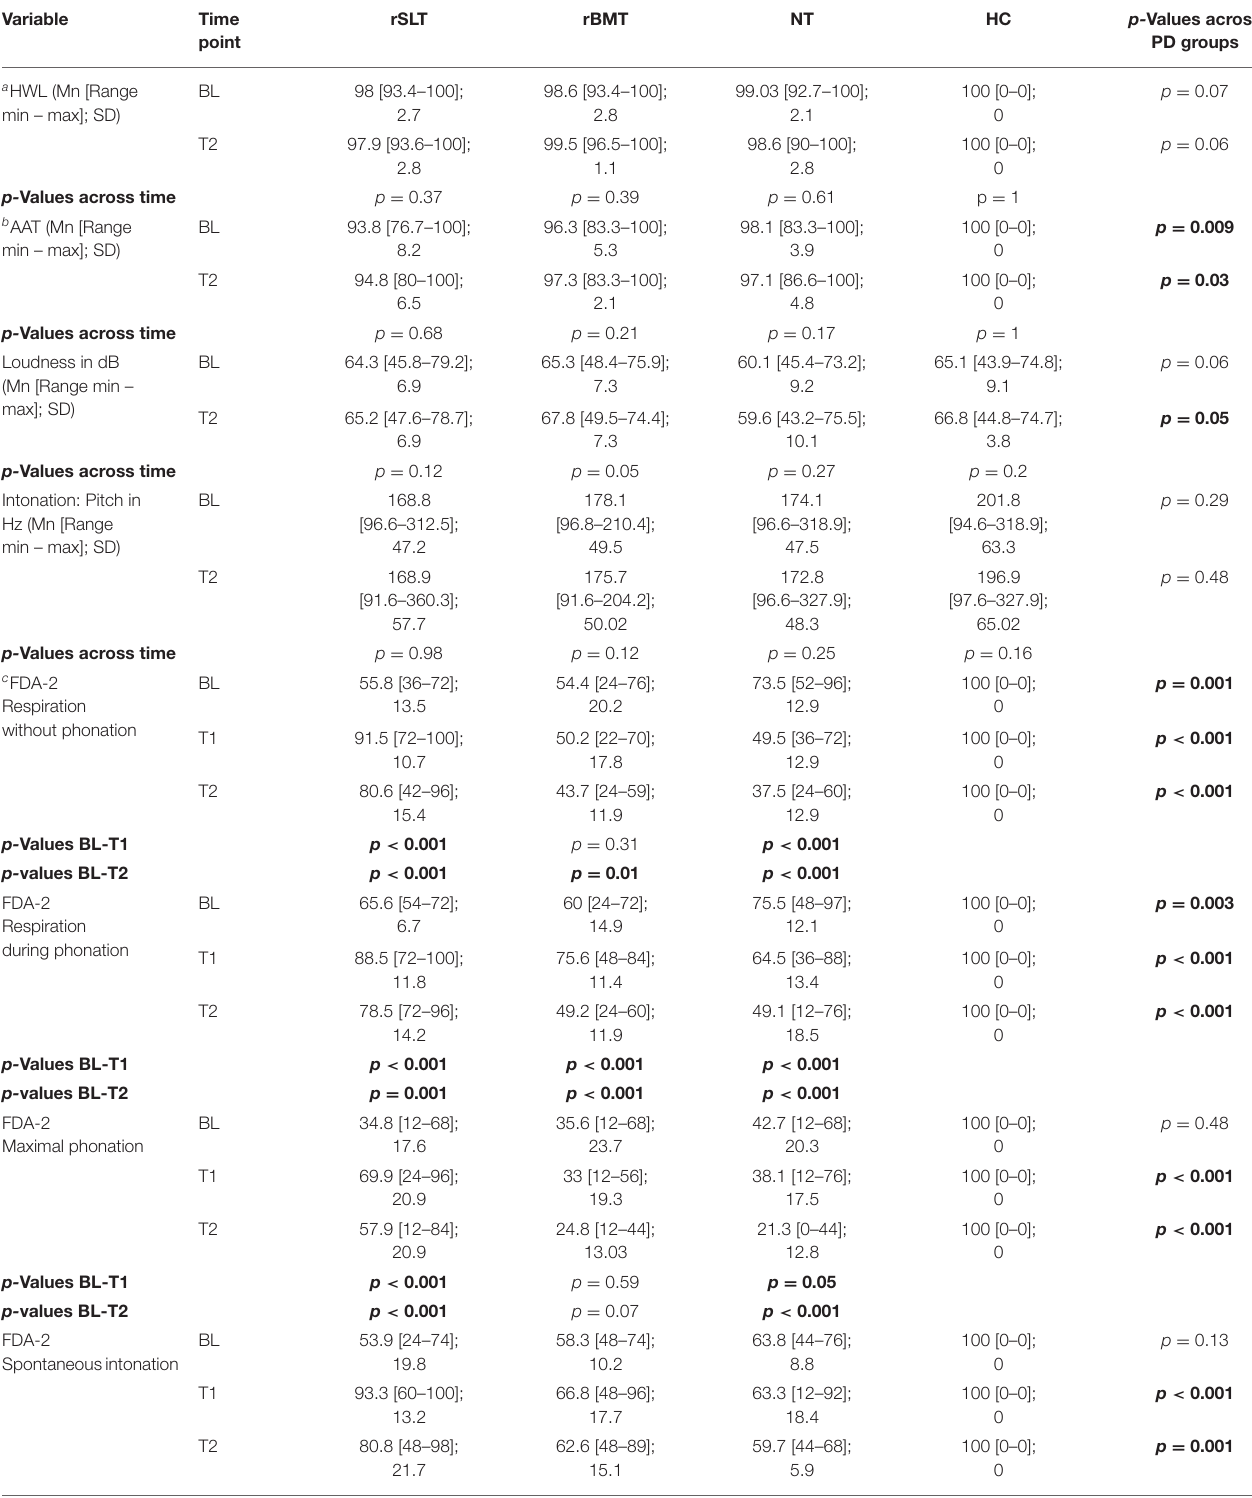
TABLE 1A | Dysarthria specific speaker